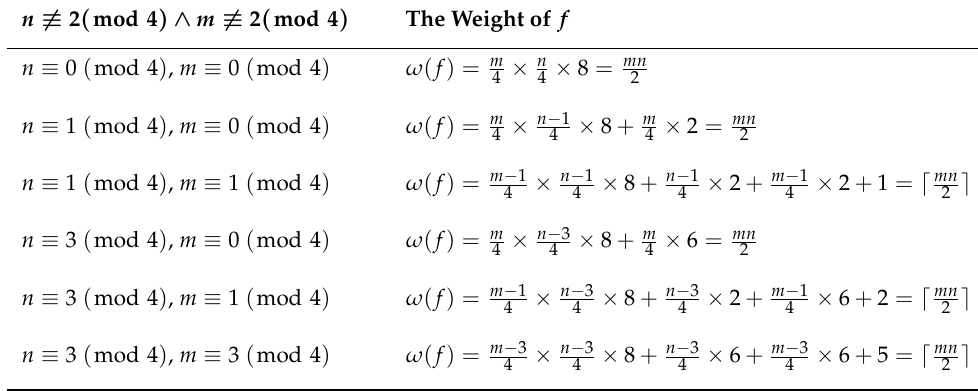
2 ( mod 4 ) m 2 ( mod 4 ) m ∧ ̸≡ ∧ (cid:54)≡